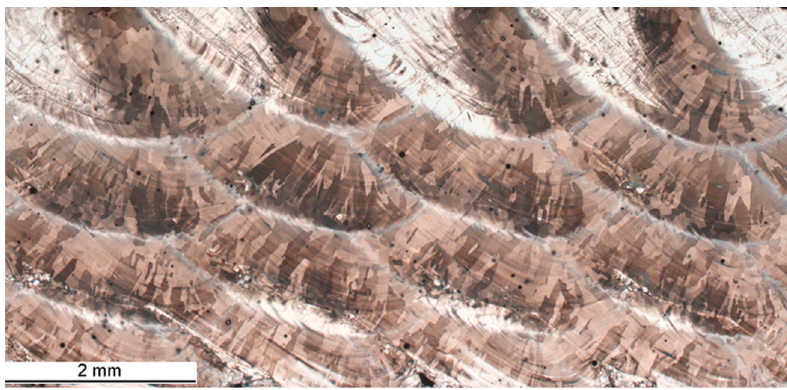
Figure 22. Microstructure overview of LMD-processed HiperFer AM (3 mm beam diameter).